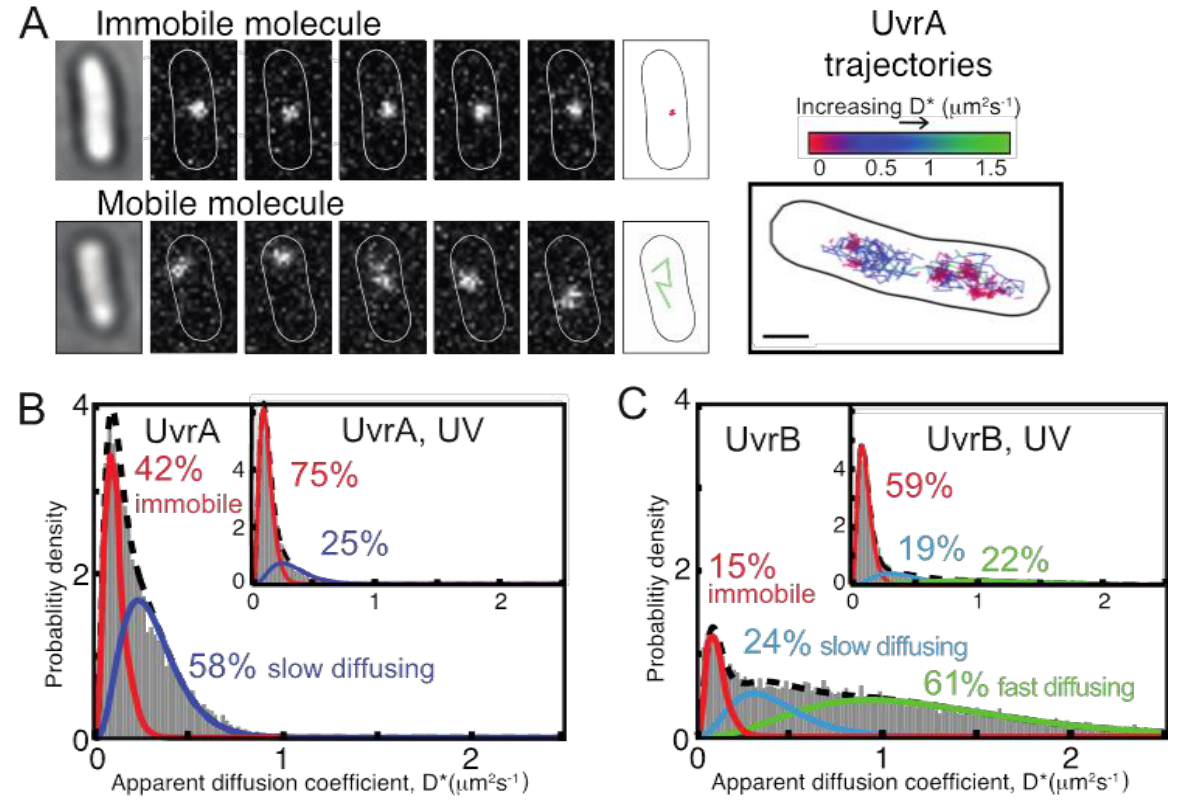
FIGURE 15: In vivo characterization of UvrA and UvrB proteins. (A) The example image of a single immobile UvrA-PAmCherry molecule localized and tracked at 15 ms exposures within five consecutive frames (top) and the example image of five consecutive frames showing fast diffusing UvrB-PAmCherry molecule (bottom). On the right, example cell is shown with multiple trajectories recorder for many indi- vidual UvrA molecules. (B) Distribution of apparent diffusion coefficients (D*) of tracked UvrA molecules, fitted with a two species model: first immobile, DNA-bound population (~42%) and second mobile population of slowly diffusing molecules (~58%). (Inset) The distribution of D* values of tracked UvrA molecules after exposure to 50 J m − 2 ultraviolet light (UV). (C) Distribution of D* values of tracked UvrB mole- cules, fitted with a three species model established that ~15% of UvrB molecules were immobile, ~24% diffusing slowly and ~61% fast diffusing. (Inset) The distribution of D* values of tracked UvrB molecules after exposure to ultraviolet light